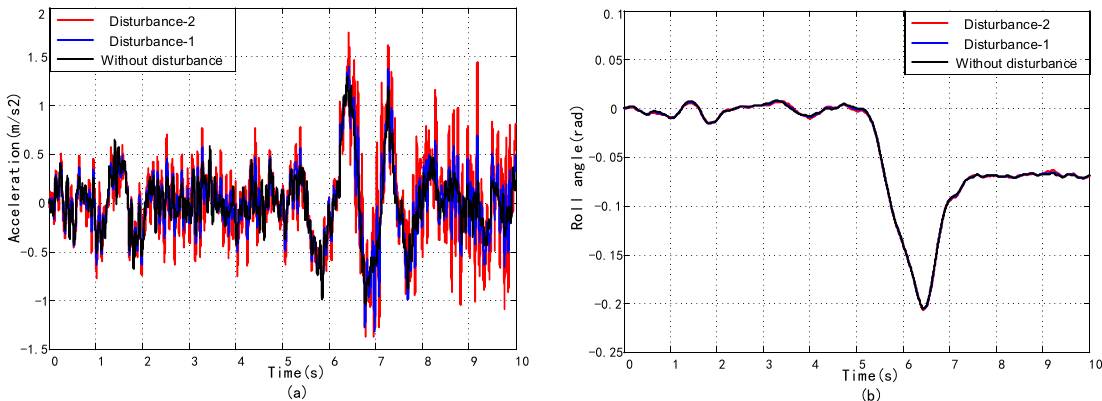
Figure 16. The robustness simulation curves with the road disturbance: ( a ) the vehicle body vertical acceleration in time domain; ( b ) the roll angle acceleration in time domain.